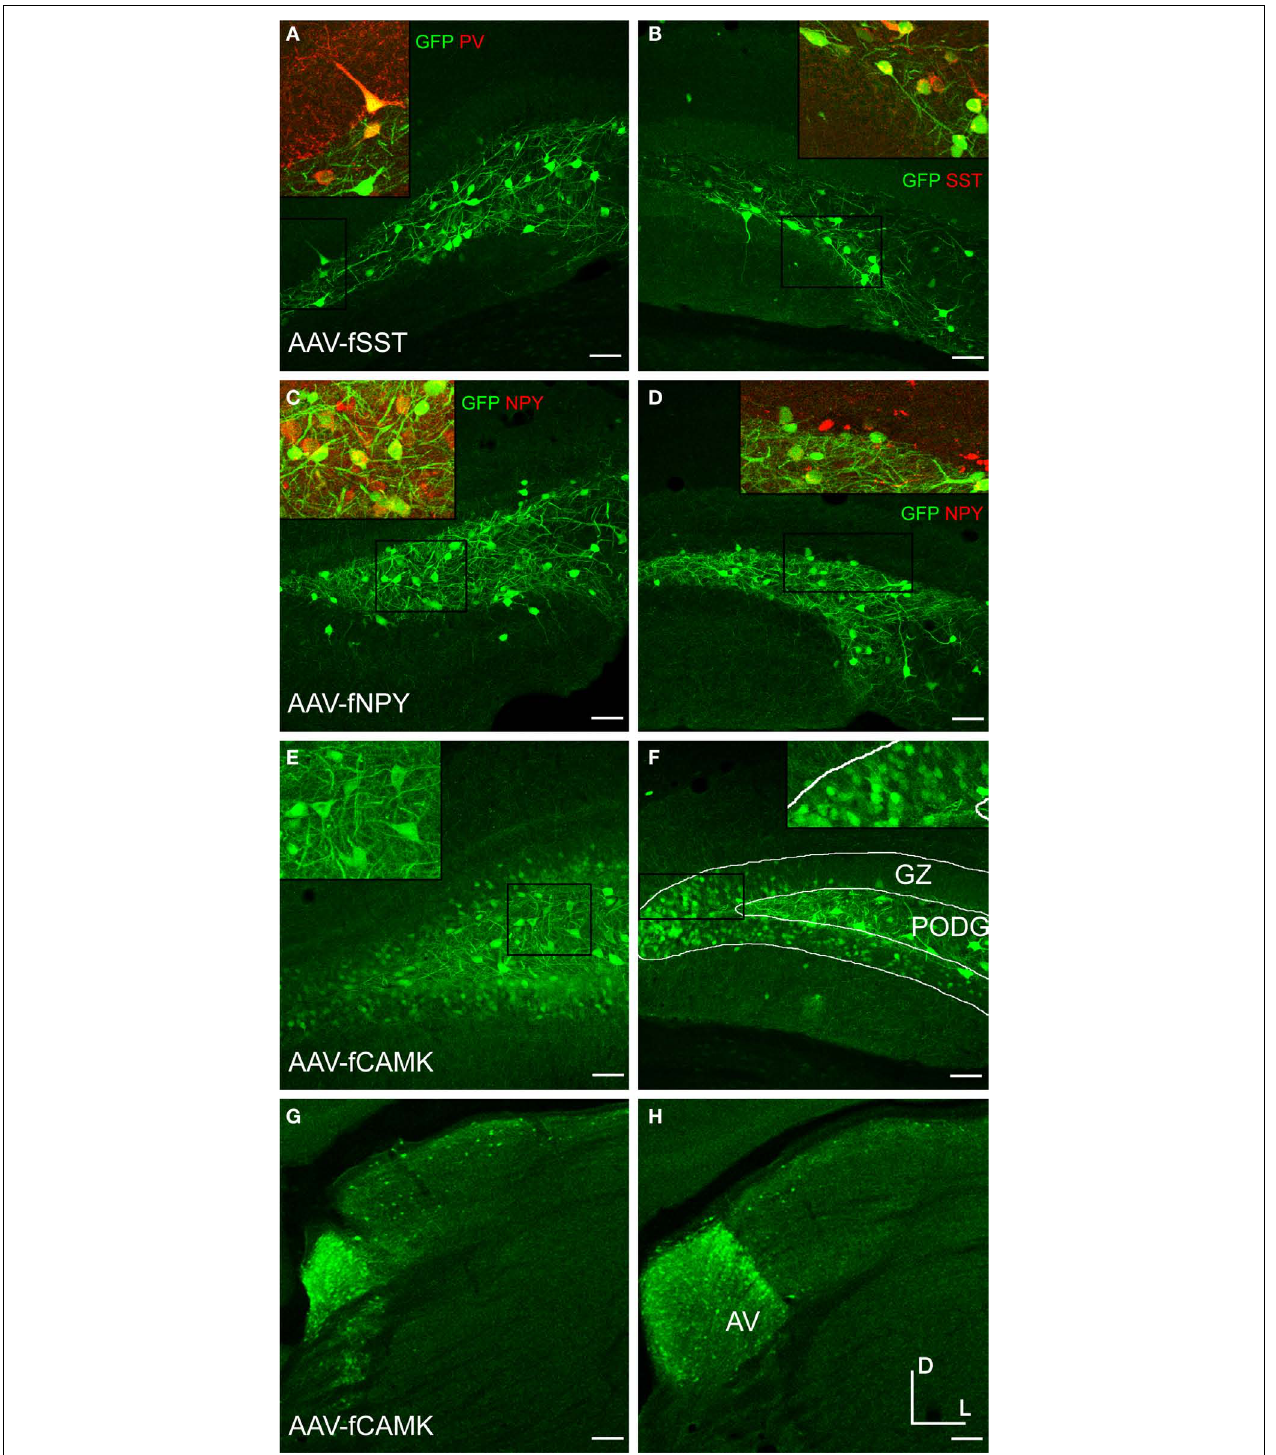
FIGURE 5 | Fugu promoters in AAV expressed in mouse dentate gyrus (DG) and thalamus. Fugu promoters in AAV drove GFP expression in subcortical areas of the DG and thalamus. Virus expression is shown in green [AAV-fSST – (A,B) ; AAV-fNPY – (C,D) ; AAV-fCAMK – (E–H) ]. Subcortical anatomical regions – granule cell layer (GZ) and polymorphic layer (PoDG) shown